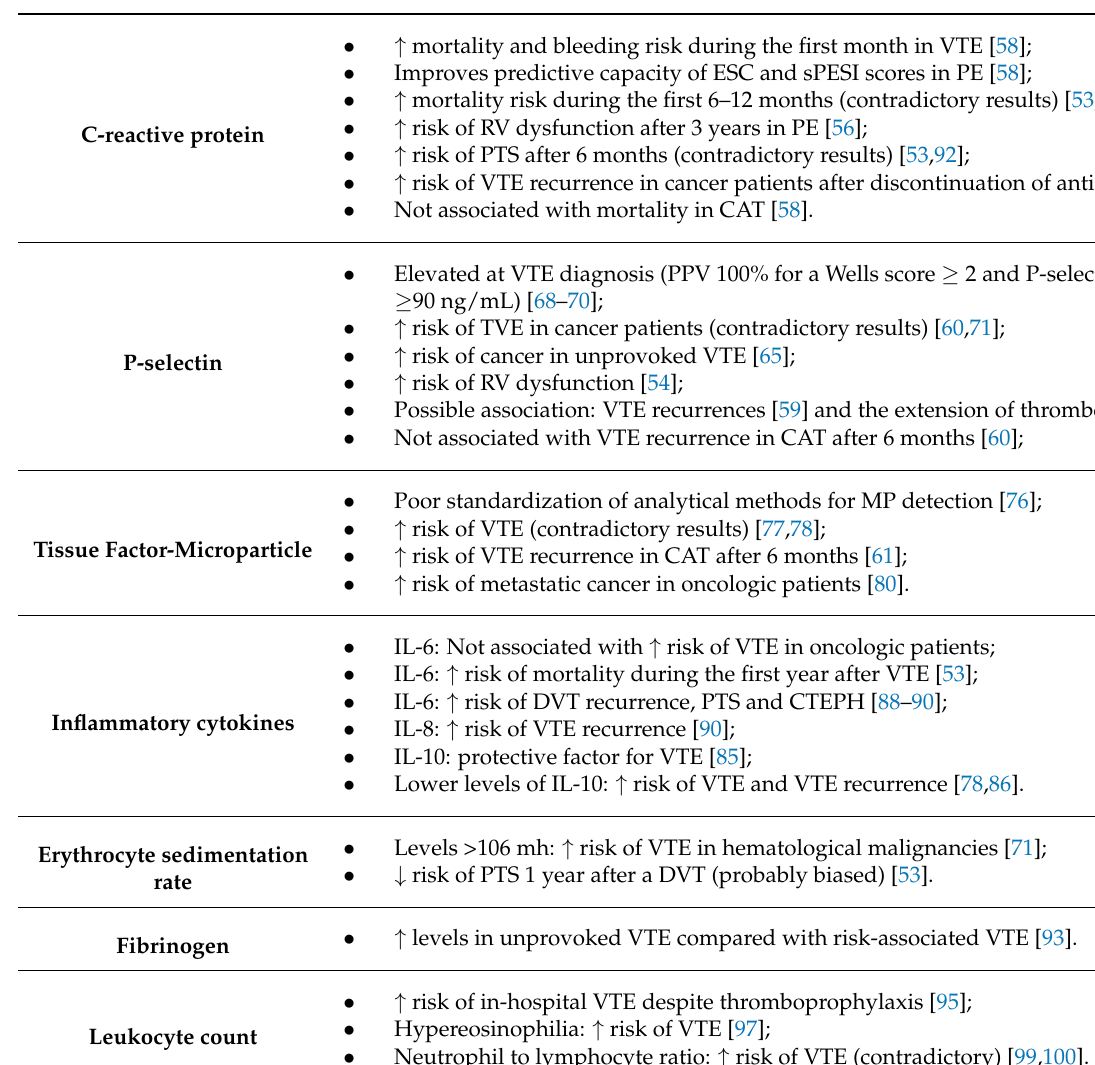
Table 2. Clinical usefulness of inflammatory